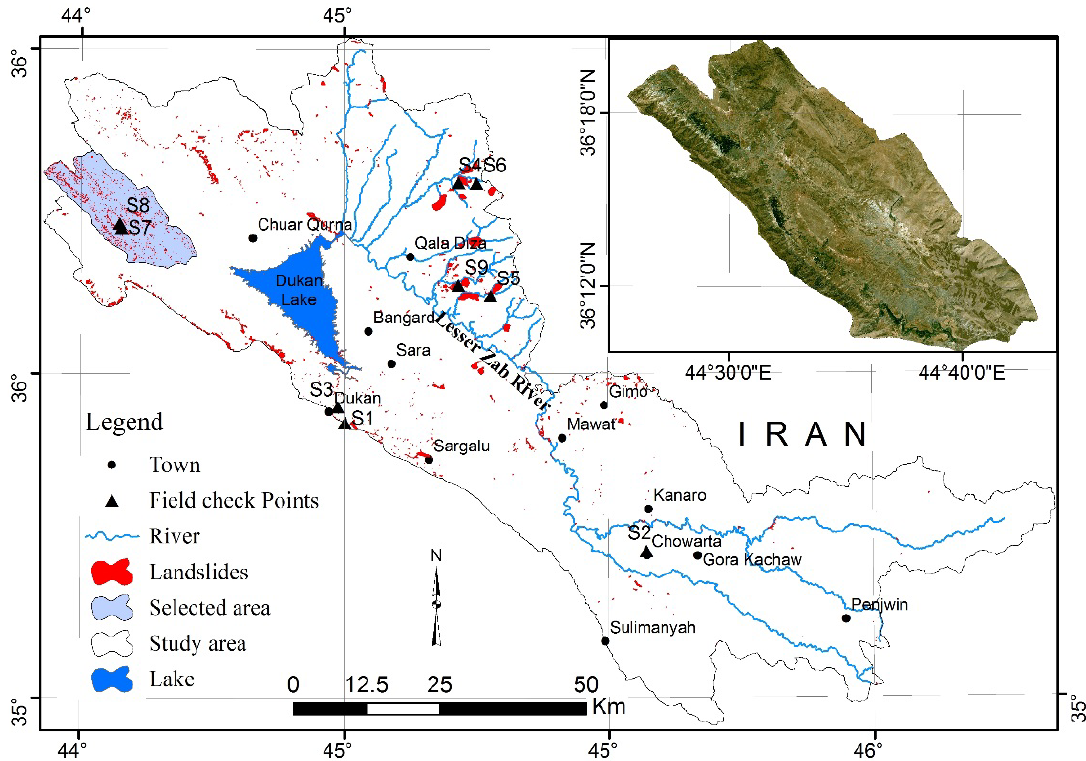
Figure 3. Landslides inventory map of 3,090 landslides identified through visual interpretation of 60 QuickBird scenes (the S1–S9 markings correspond to sites mentioned in Section 2.3 and Figures 4 and